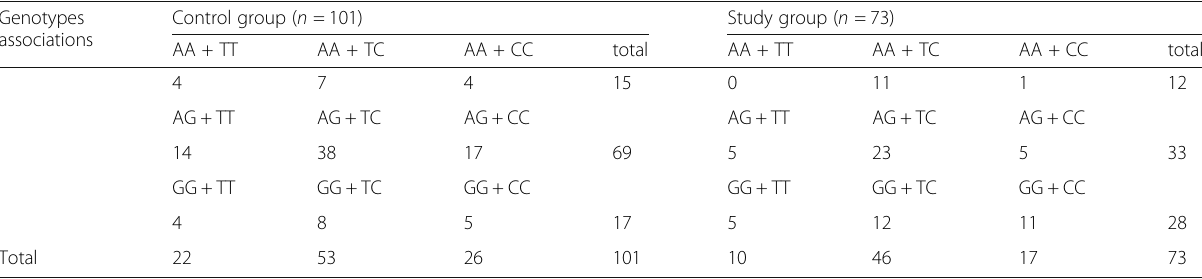
Table 5 Frequency distribution of the genotypes of the association between Pvu II and Xbal polymorphisms in patients with precocious puberty and normal puberty Genotypes associations